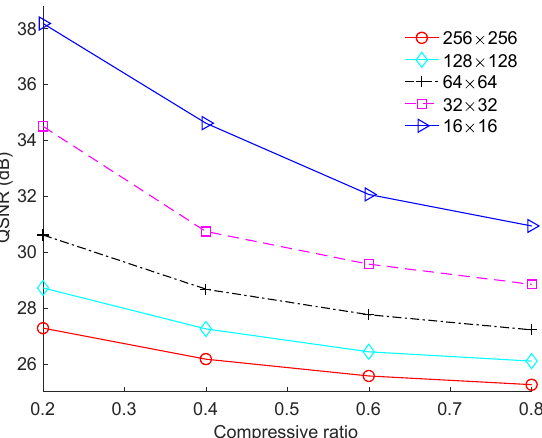
Figure 9. Effect of block size on QSNR performance for the “Cameraman” image under a 5-bit resolution of ADC.